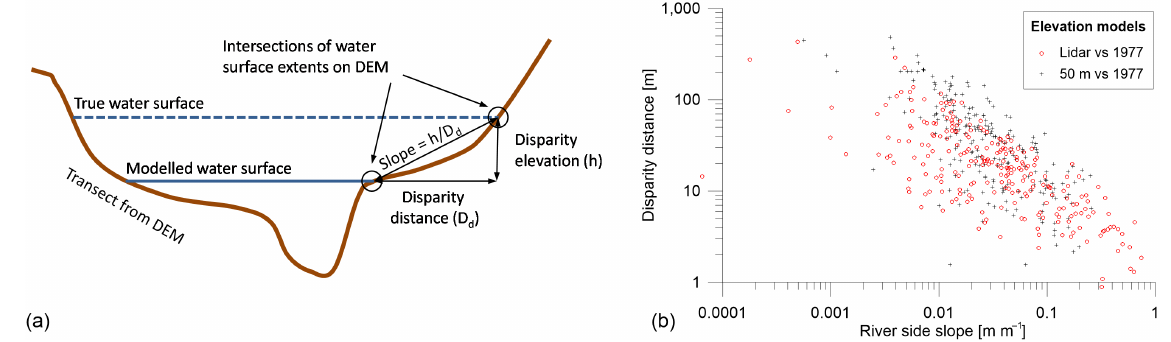
Figure 1. (a) Calculation of disparity distances. (b) Relation between disparity distance and slope in the Testebo River (values from Lim,